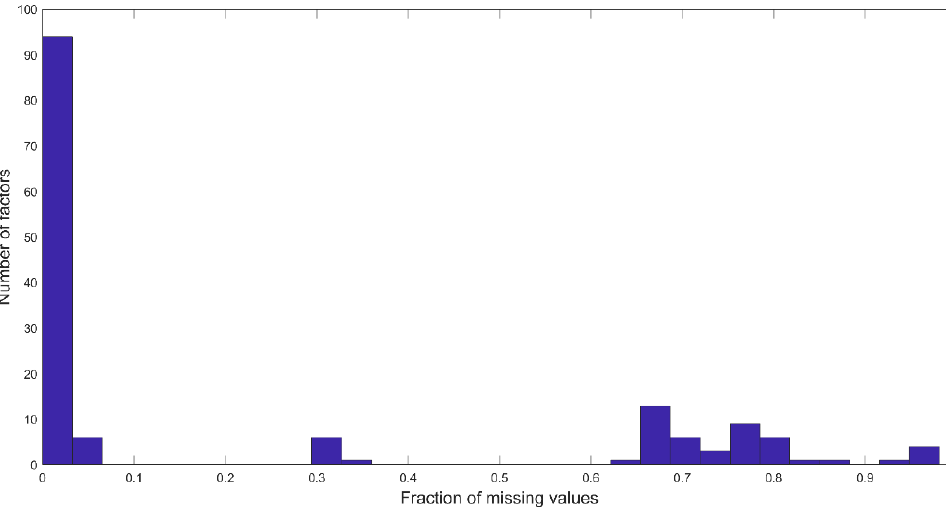
Figure 1. Histogram of the fraction of missing values per factor. Factors with over 50% missing values were removed.